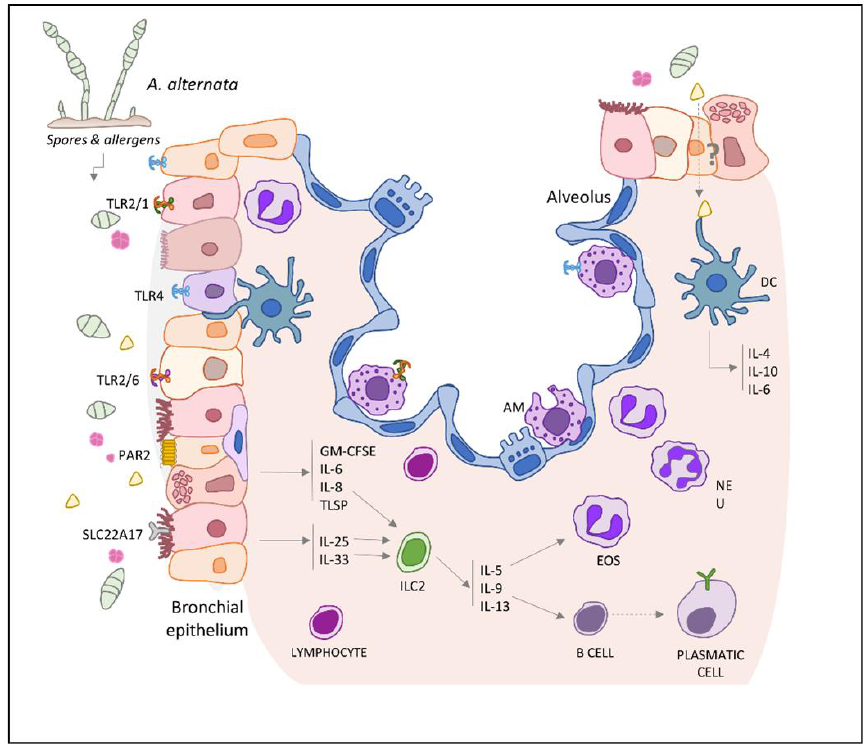
Figure 2. Immune responses induced in airway epithelium by Alternaria alternata . Spores and my- celium fragments containing allergenic compounds (such as Alt a 1) can reach upper airways,